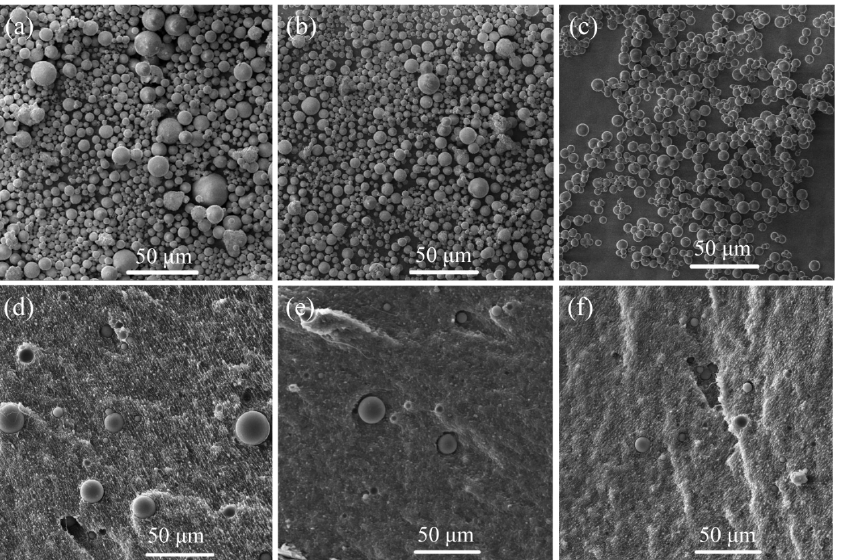
Fig. 2 SEM images of microsphere: (a) UF, (b) 75 DN, and (c) PAAm. Fracture section of the composite samples: (d) UF composite, (e) 75 DN composite, and (f) PAAm